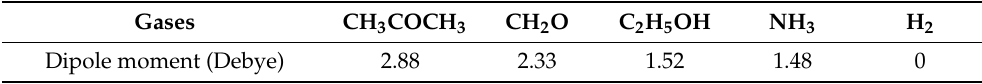
Table 3. Experimental polarity of the studied gases